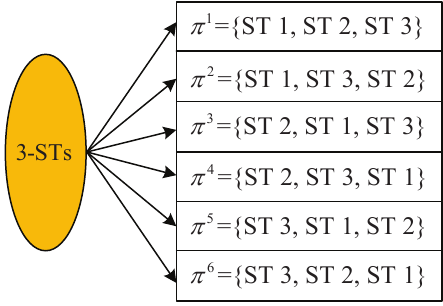
Figure 2. An illustration of different decoding-orders for an example of I = { 1,2,3 }